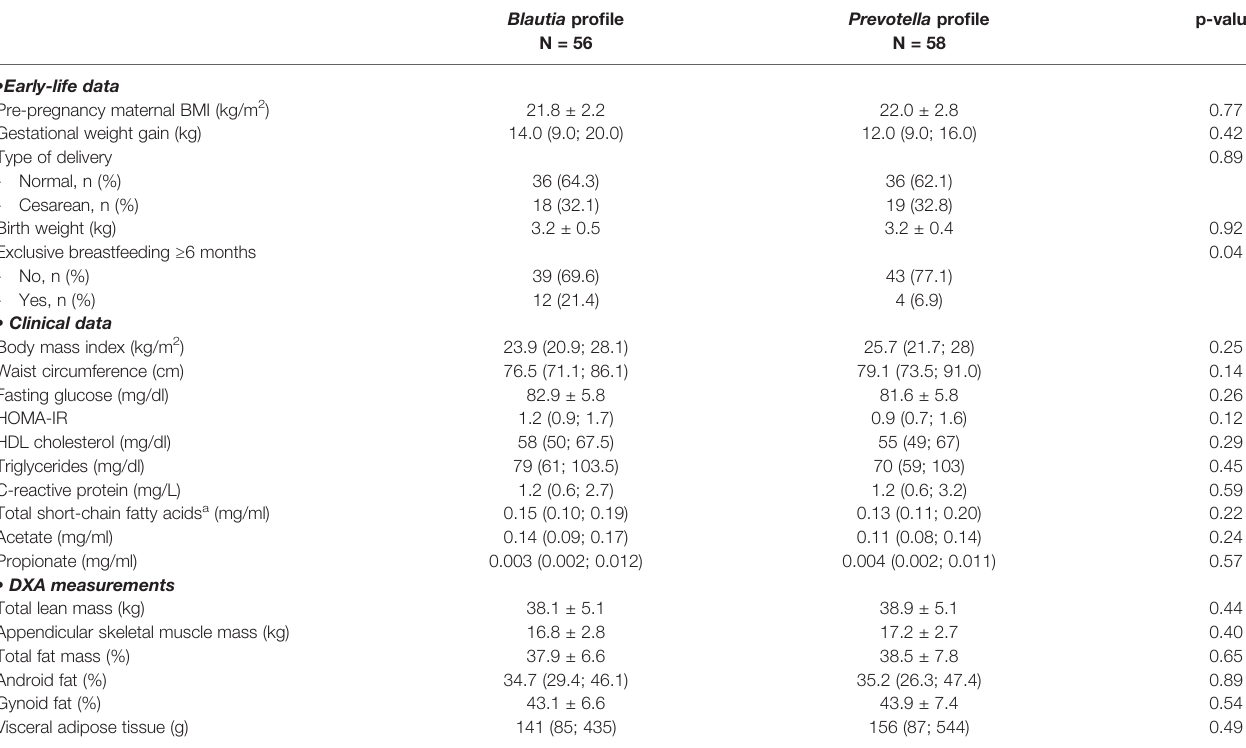
TABLE 1 | Means (standard deviation) or medians (interquartile range) for clinical variables and body composition parameters of the 114 participants according to pro fi le. Blautia pro fi le